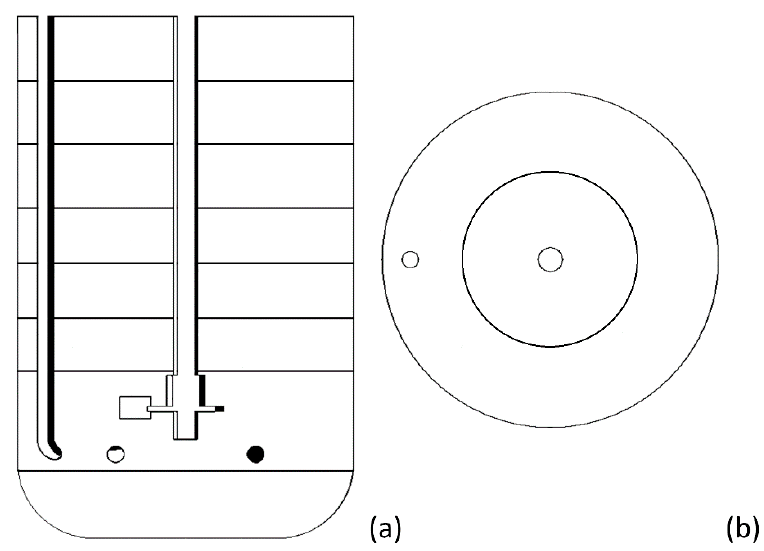
Figure 4. Arrangement of compartments; side ( a ) and top ( b ) views. Processes 2017 , 5 , x FOR PEER REVIEW Table 2. Unstructured model parameters.